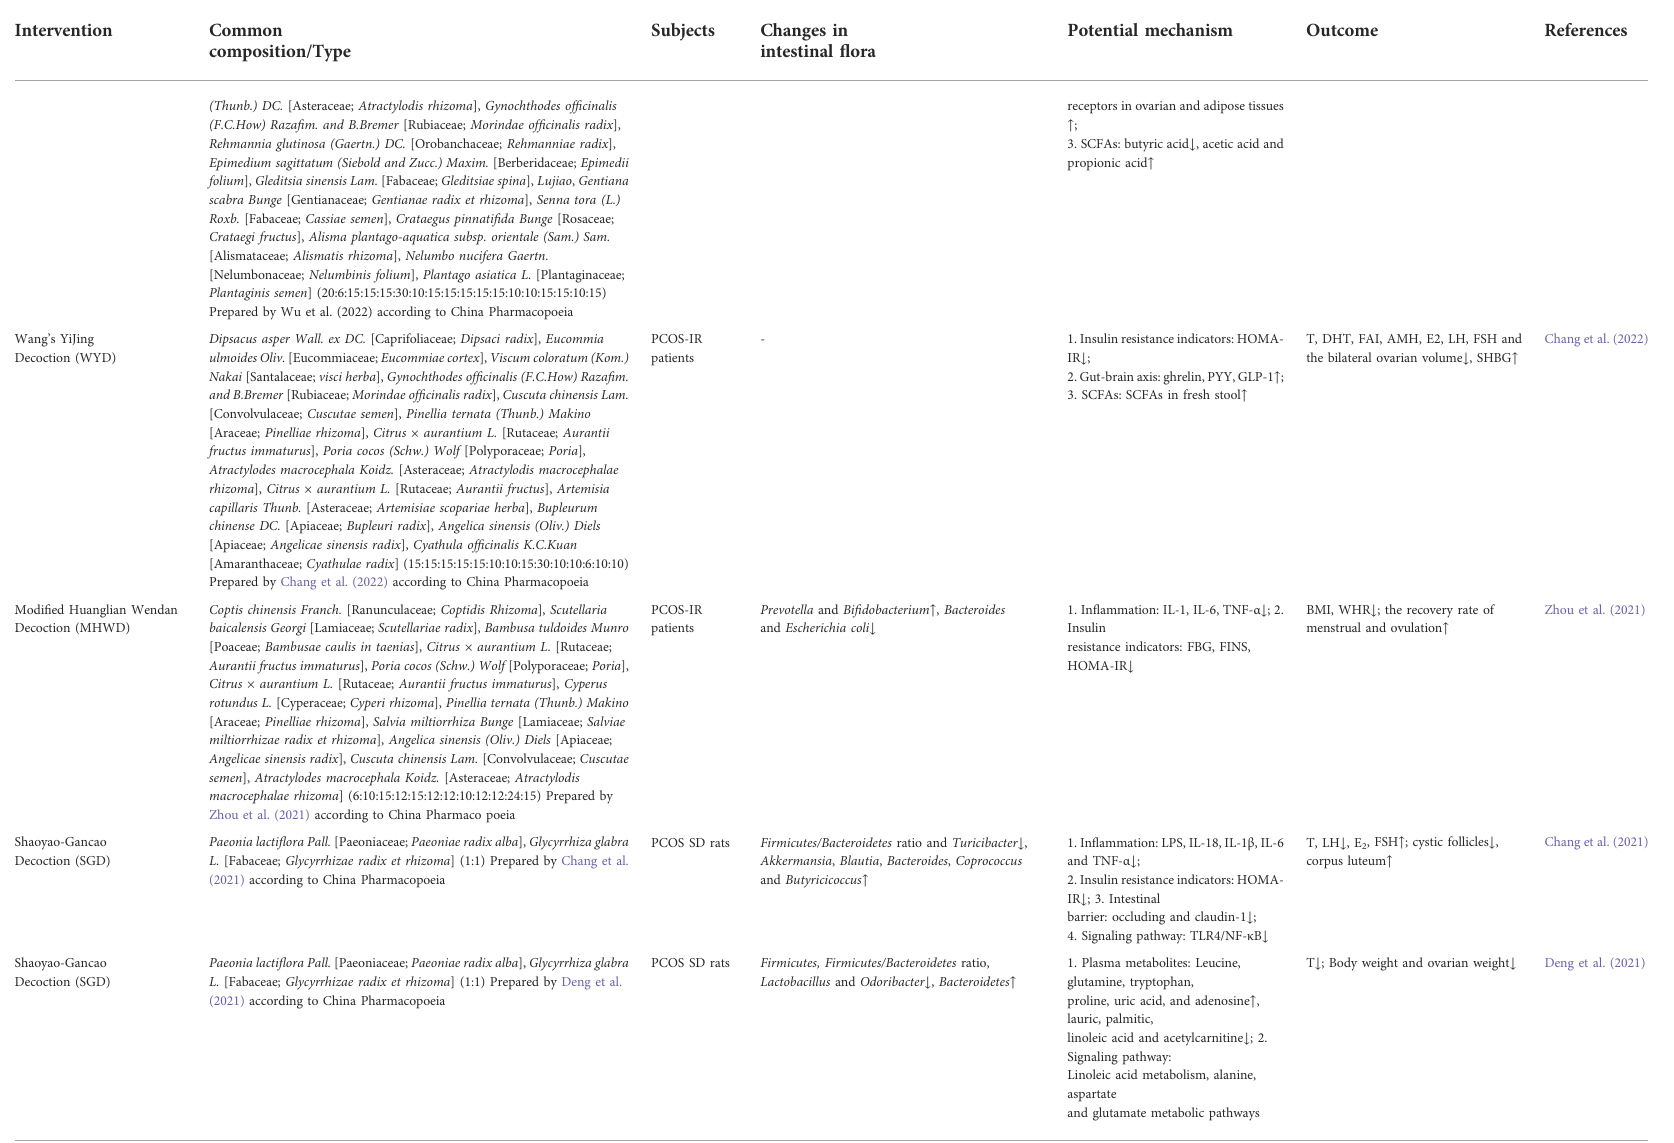
T, LH ↓ , E 2 , FSH ↑ ; cystic follicles ↓ , corpus luteum ↑